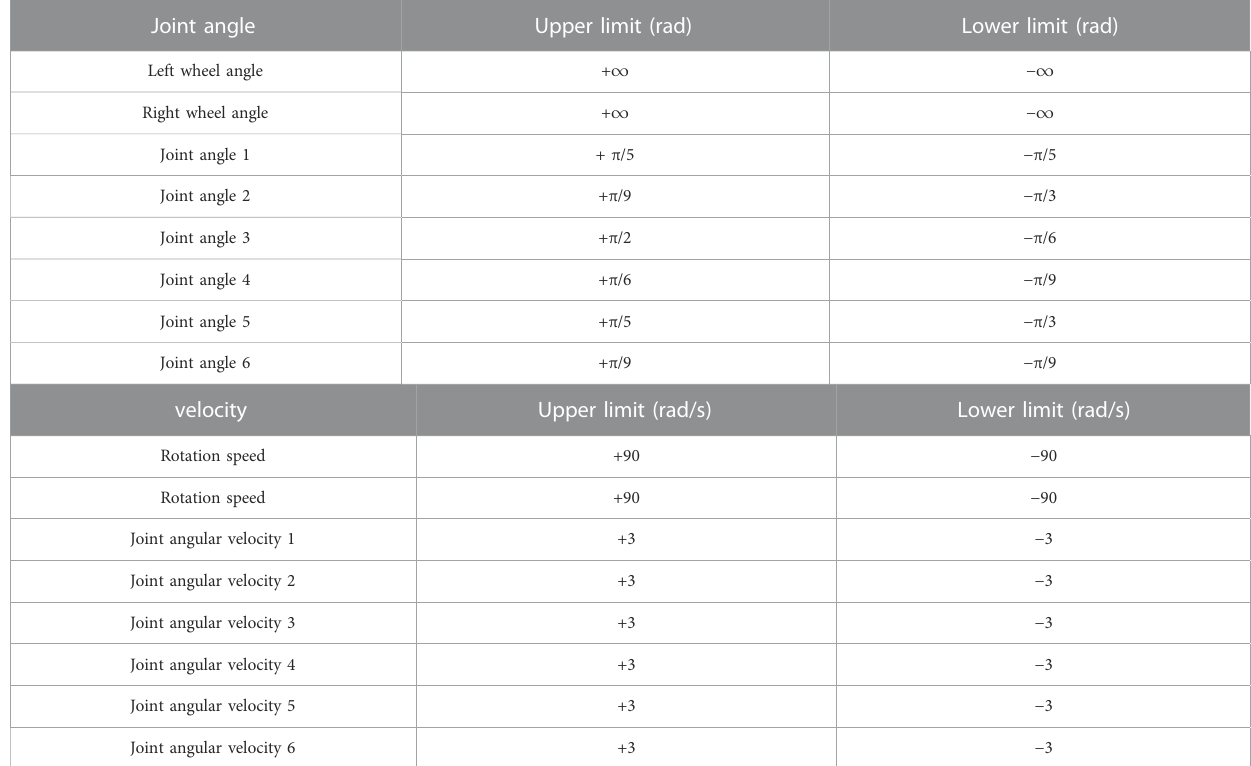
TABLE 2 Physical constraints of the robotic arm. Joint angle Upper limit (rad) Lower limit